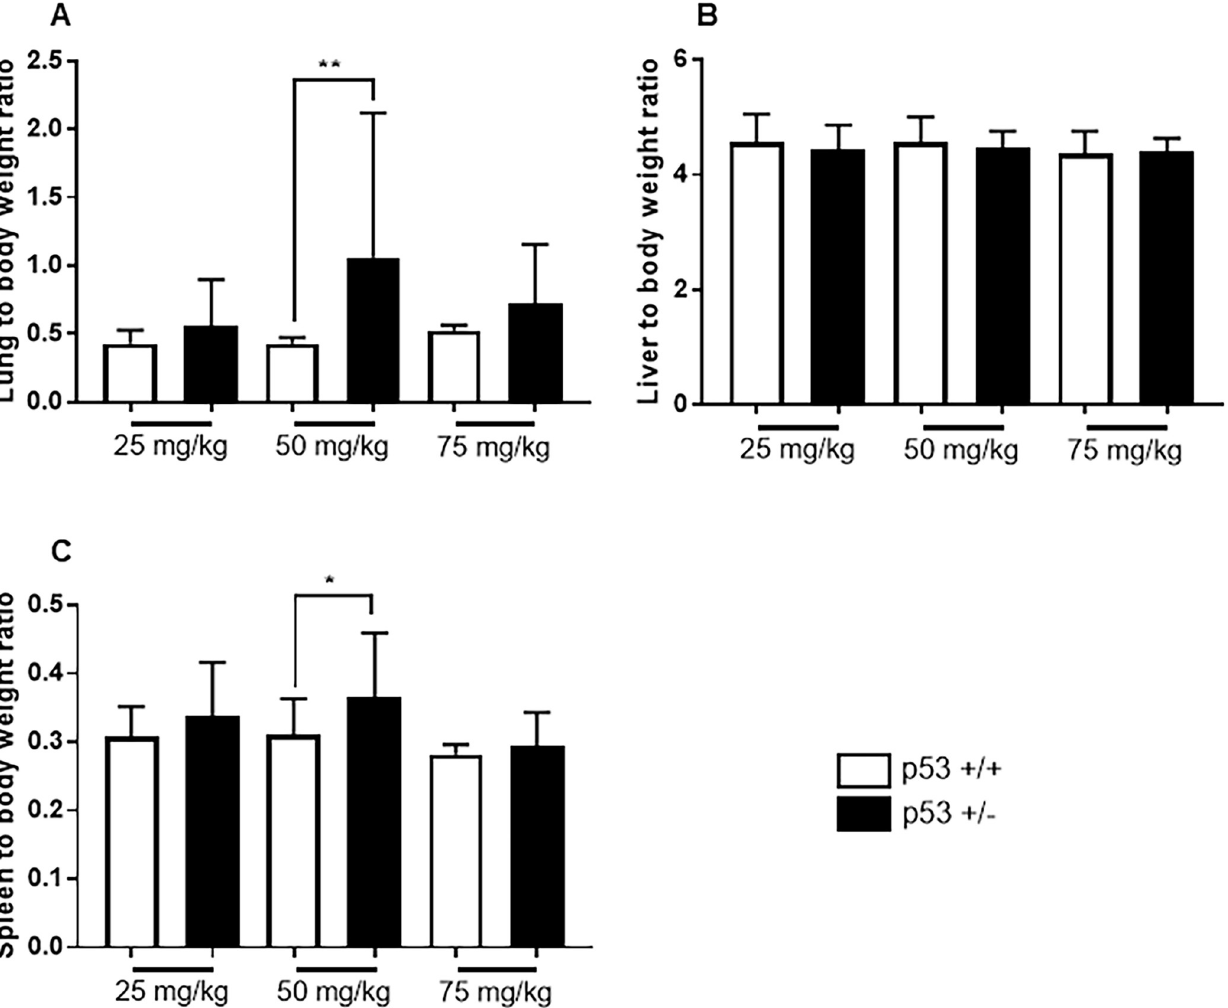
Fig 2. Relative organ weights after MNU administration in different dosages. (A) shows lung to body weight ratio, (B) shows liver to body weight ratio, and (C) shows spleen to body weight ratio in the mice survived until the end of the experiment. Data are represented as mean ± SD. � P < 0.05 and �� P < 0.01 versus wild type mice, as assessed using two-tailed t